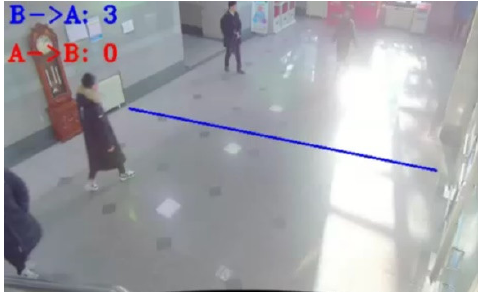
Figure 6. Example of counting line.